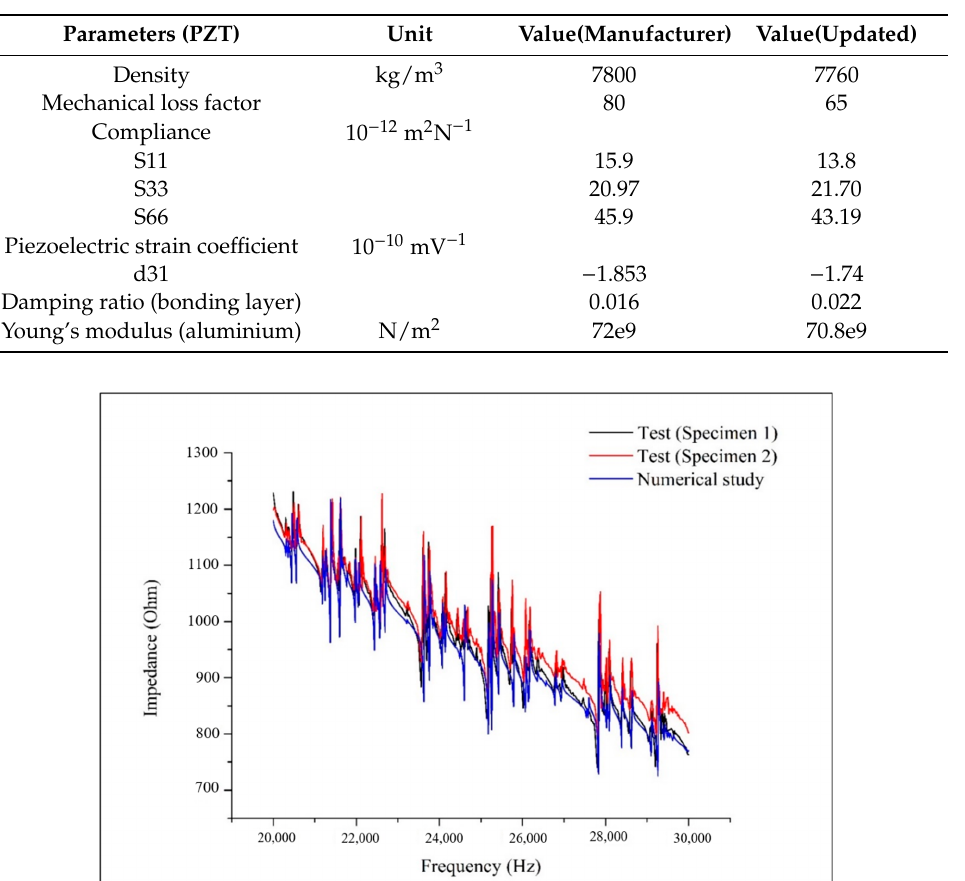
Figure 6. Comparison of the impedance responses from test specimens and the developed coupled finite element model.